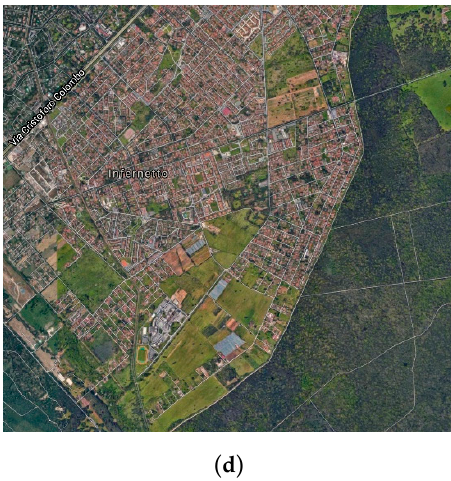
Figure 8. Aerial photographs illustrating a few examples of peri-urban landscapes in Rome (significant place’s names are included); ( a ) industrial settlements at the cropland-forest fringe, ( b ) discontinuous coastal settlements, ( c ) pre-existing rural settlements in a mixed agricultural landscape, ( d ) data source: Google Earth imagery (2018).